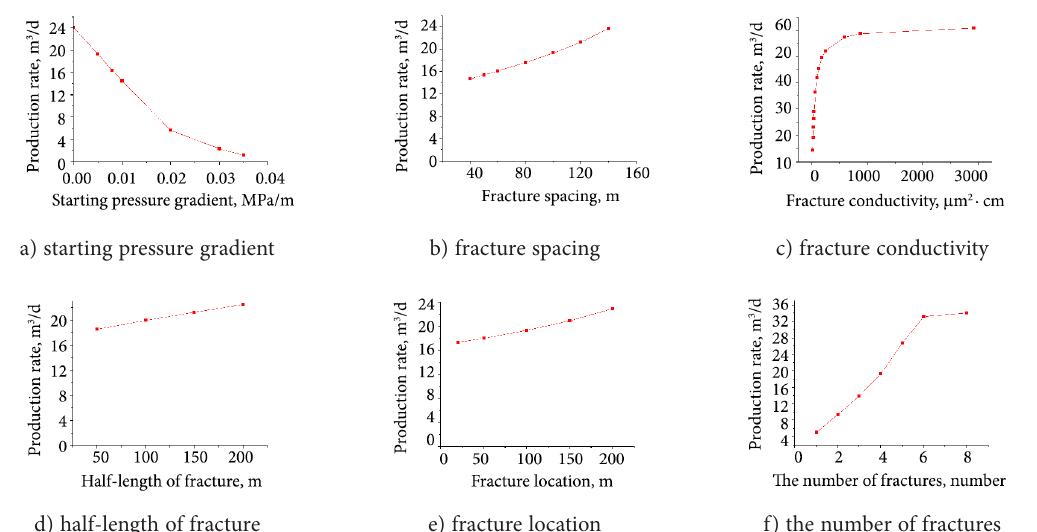
Figure 9. Relationship between oil well production and sensitive